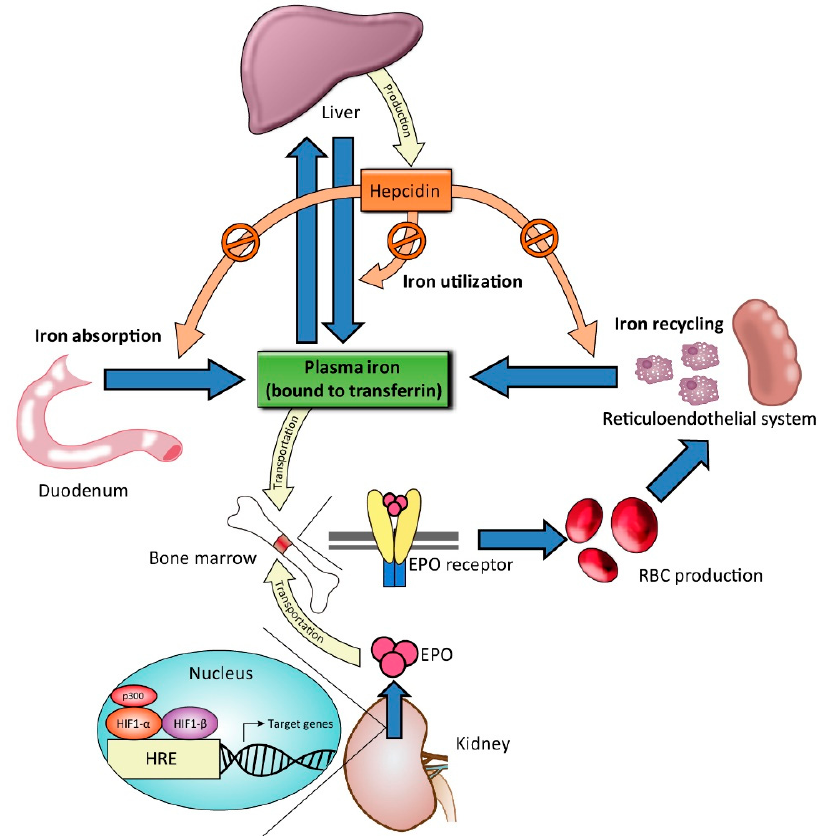
Figure 1. Illustration of iron metabolism. Dietary iron is absorbed from the duodenum. In plasma, iron is bound to transferrin for transport. Some of the iron is stored in the liver through binding to ferritin. The remaining iron is transported to bone marrow for red blood cell (RBC) production, a process stimulated by erythropoietin (EPO), which is secreted by the kidney. EPO transcription is upregulated by hypoxia inducible factors (HIFs), which are transcription factors stabilized under hypoxic conditions. The process involves recruitment of coactivators, such as p300, and binding of HIF and p300 to the hypoxia-response element (HRE) of the EPO gene. RBCs are destroyed at the end of their lifespan by macrophages in the reticuloendothelial system (e.g., in the spleen), and their iron is then recycled. Hepcidin, mainly produced by the liver, plays a central role in the regulation of iron metabolism by downregulating iron absorption and iron utilization under conditions of infection and